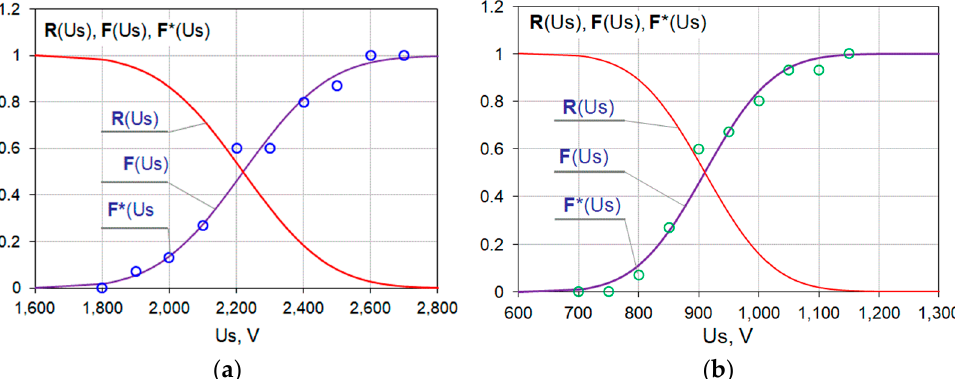
Figure 10. Distribution of empirical distribution F*(Us) and theoretical F(Us) and theoretical strength function R(Us): ( a ) LED lamp A, ( b ) LED lamp B. Table 4. Results of statistical analysis for LED lamps of A and B types.